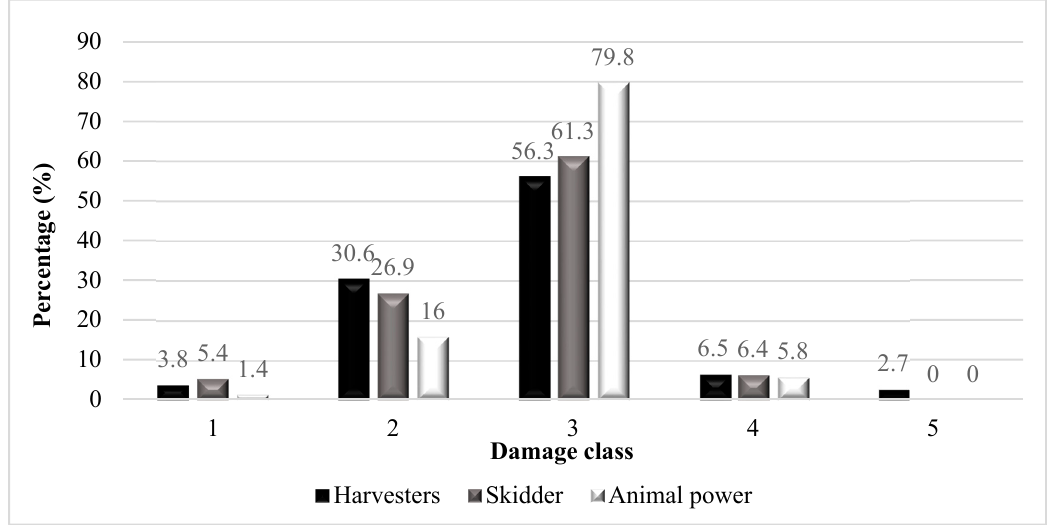
Figure 3. Percentage proportion of wounds at different locations along the stem.